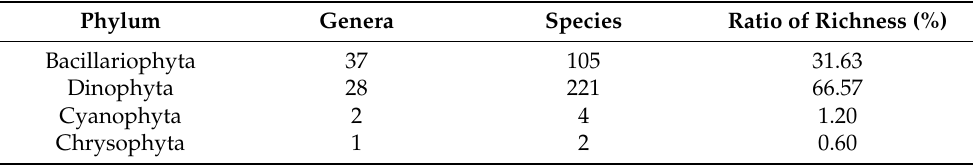
Table 1. The numbers of phytoplankton species and genera in the WPO.